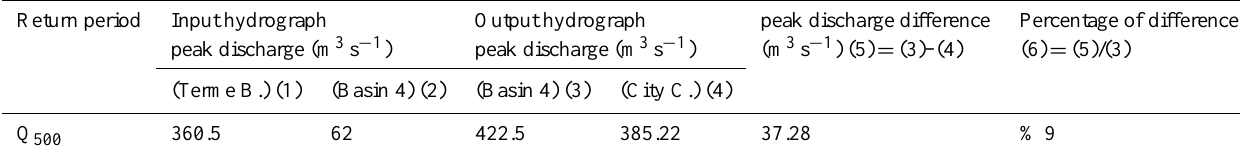
Table 6. Scenario5 model